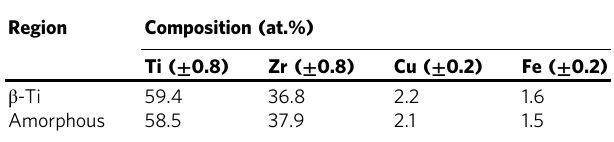
Table 1 Mean composition of β -Ti and the amorphous regions in the ingot of Ti 59.1 Zr 37 Cu 2.3 Fe 1.6 measured by EDS in the TEM Region Composition (at.%)